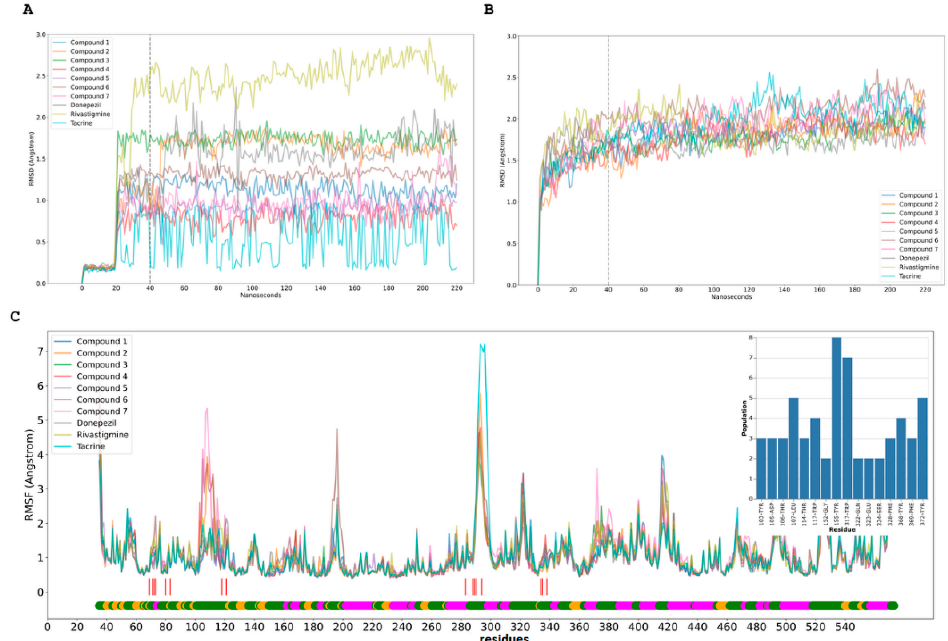
Figure 7. Molecular dynamics simulation (MDS) of compound and human AchE. ( A , B ). RMSD of compounds ( A ) and human AChEs ( B ) from MDS trajectory. RMSD for each compound assay with the line after 20 ns of equilibration with restraints; 20 ns after release the restrictions, the last 180 ns were used to RMSF calculations. ( C ). Human AChEs RMSF from MDS trajectory. These RMSF plots contain the low bar with the secondary structure f AChE, coil (green), sheet (yellow), and helix (magenta); the red line shows the more populated residues from the cluster analysis for each MDS and the compounds’ interaction.